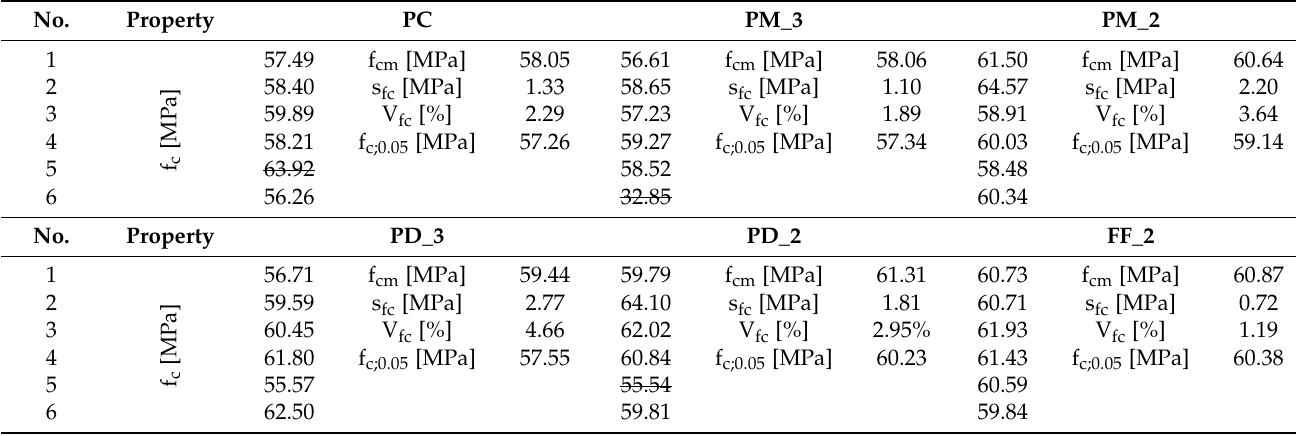
Table 7. Compressive strength for all samples for individual concrete